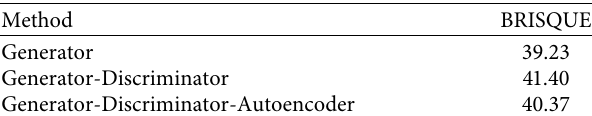
Figure 3: Music consistency rating Table 3: Image quality assessment score.